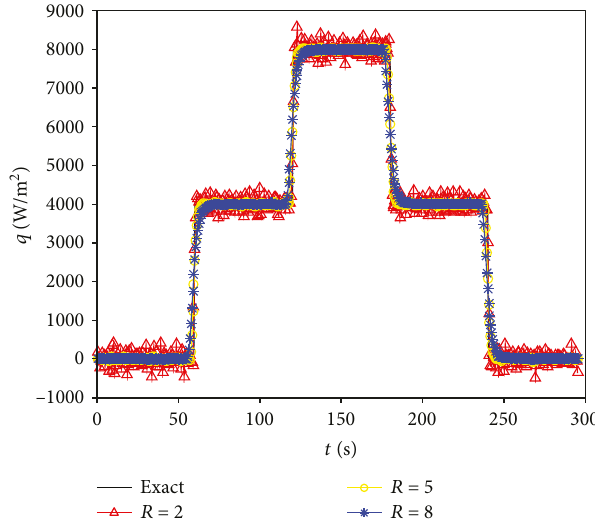
Figure 4: The history of measured and calculated temperatures for di ff erent future time steps when σ = 0 00 and L = 0 01 m